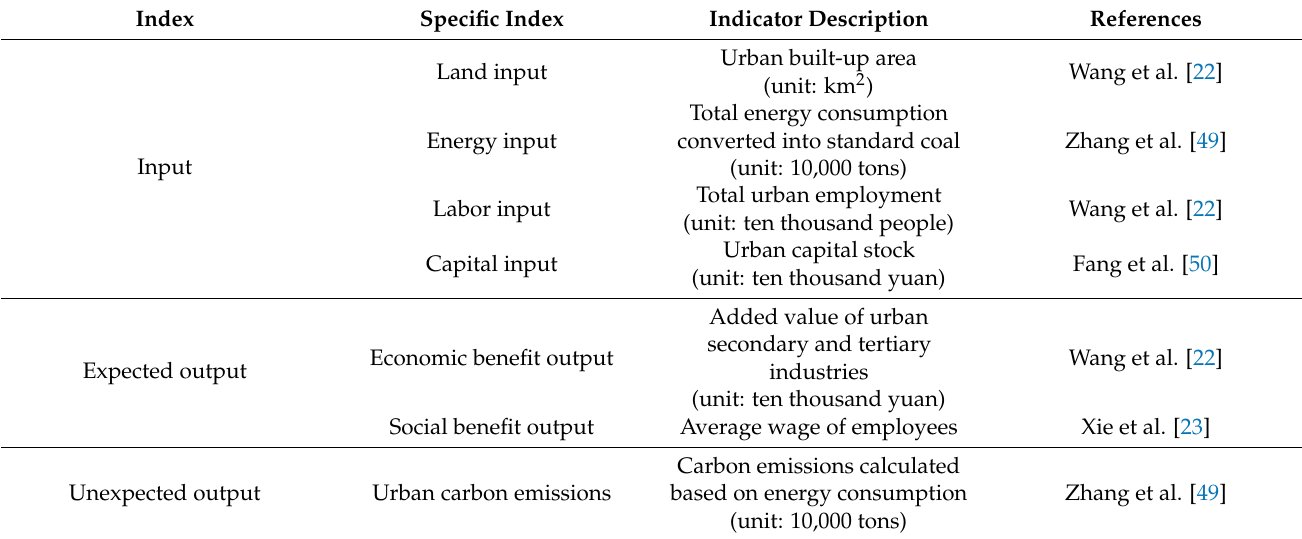
Table 1. Index system of the low-carbon utilization efficiency of urban